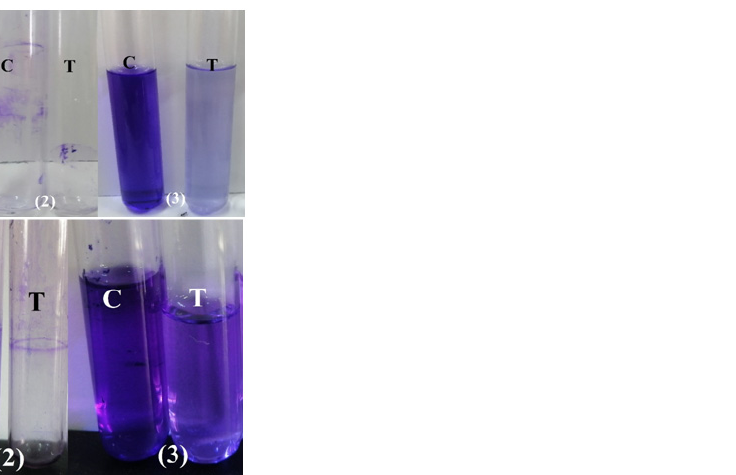
Figure 8. Antibiofilm potential of the synthesised ZnCe x Fe 2 − x O 4 ; X = 0.06 using the tube method against Staphylococcus aureus ( a ) and Candida albicans ( b ); where the steps are reported as follows: (1) growth of the bacterial and yeast cells and biofilm formation (rings) without the treatment with the synthesised ZnCe x Fe 2 − x O 4 ; X = 0.06 and inhibition of the bacterial and yeast growth after treatment with ZnCe x Fe 2 − x O 4 ; X = 0.06; (2) staining of the adherent bacterial and yeast cells with crystal violet, and (3) removal and dissolution of the adherent bacterial and yeast cells by ethanol for semi-quantitative biofilm inhibition determination. Table 3. Semi-quantitative inhibition of biofilm formation for bacterial and yeast pathogens non-treated and treated with ZnCe x Fe 2 − x O 4 ; X = 0.06. Bacterial and Yeast Strains